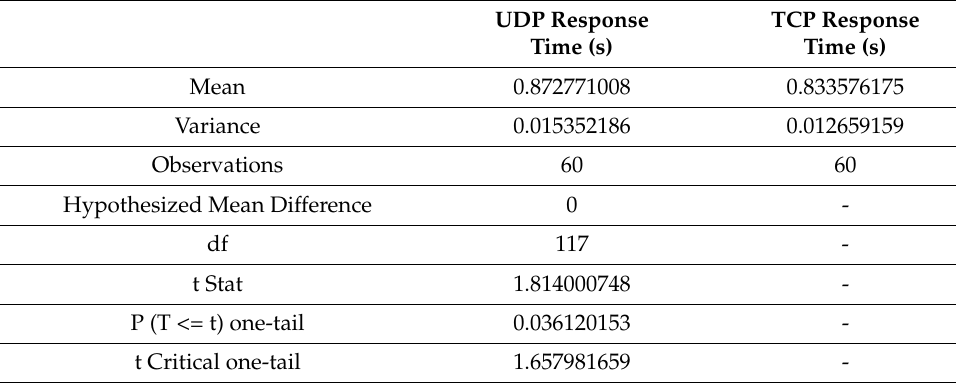
Table 5. Results, Experiment 2.